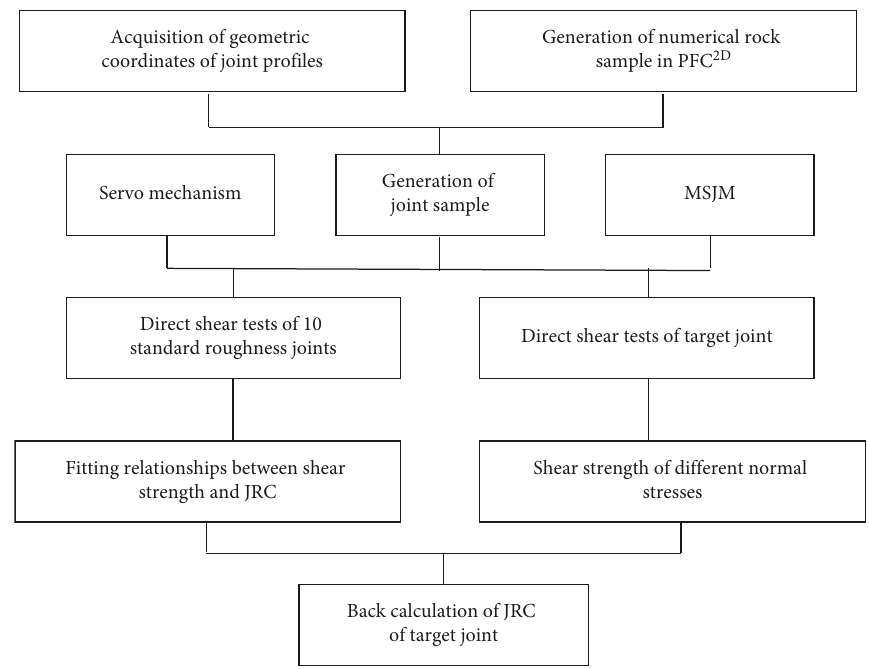
Figure 3: Procedure of the proposed